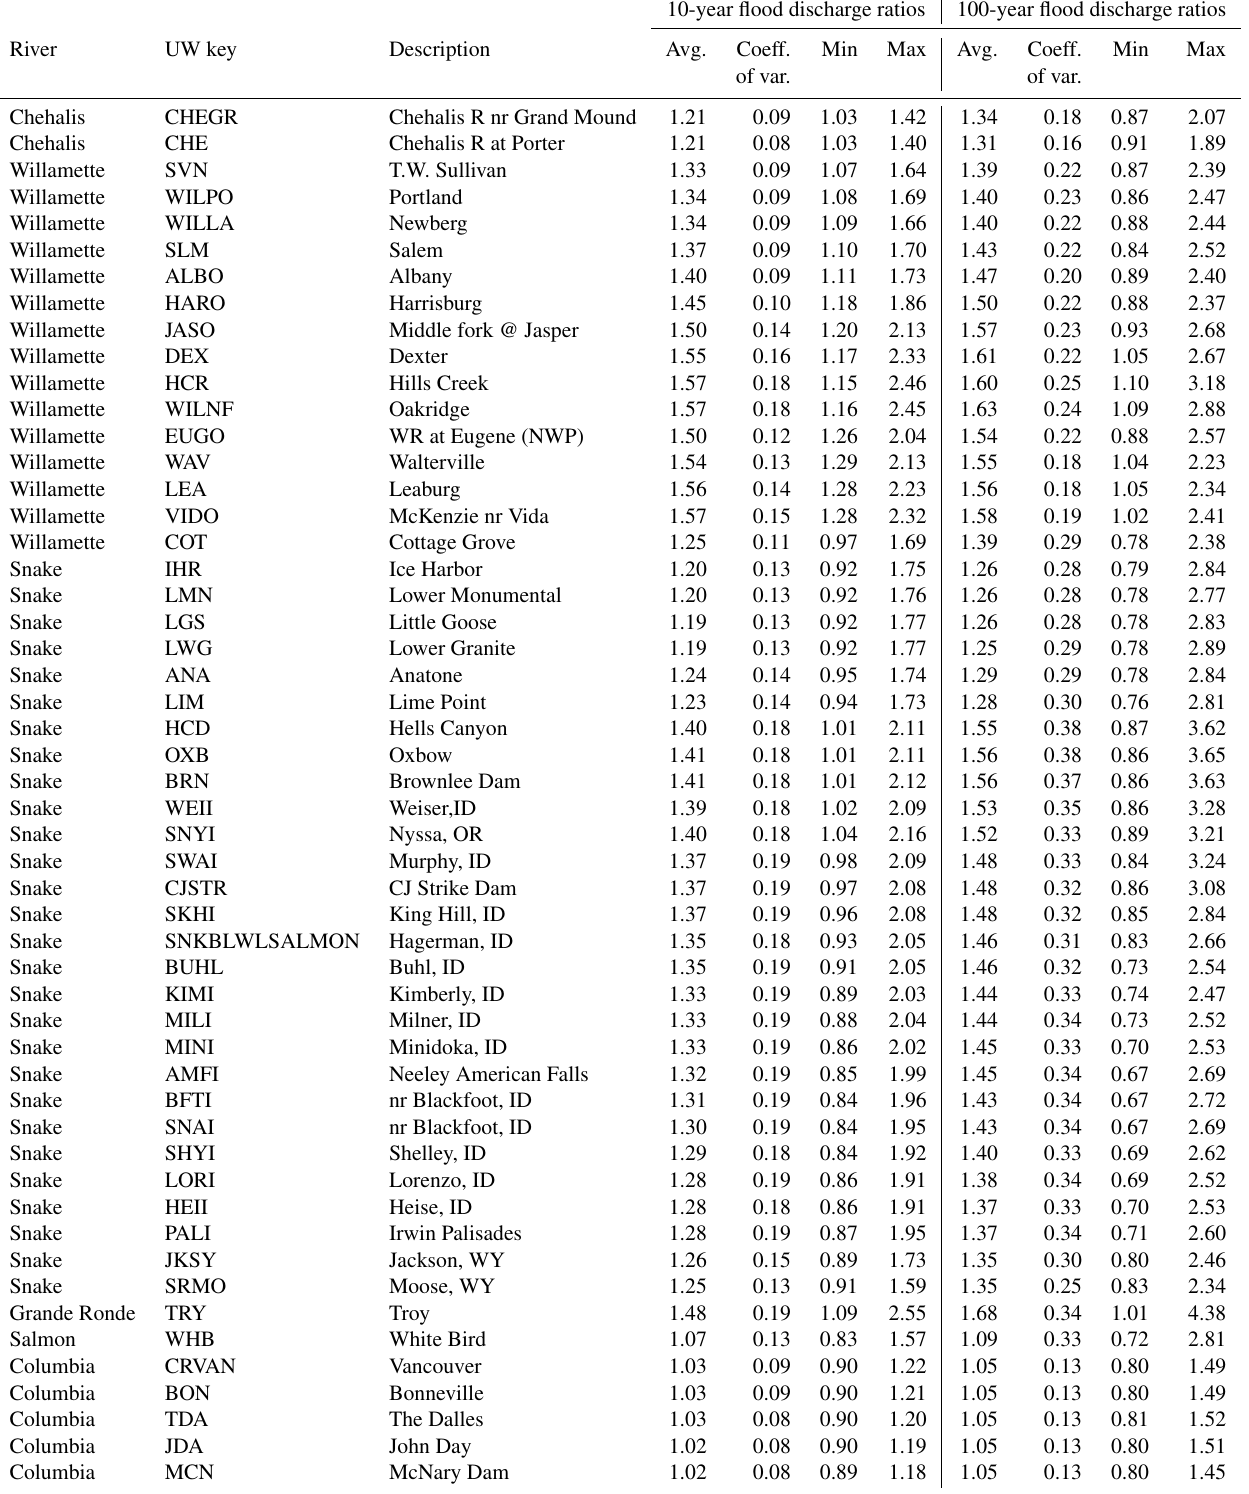
Table 1. Information about locations featured in this paper – location, river, and discharge